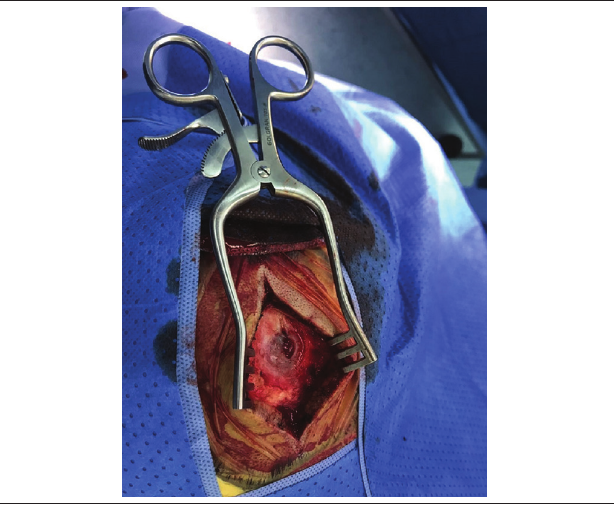
fIgure 5 – Craniotomy with surgical margin and resection of the lytic bone lesion